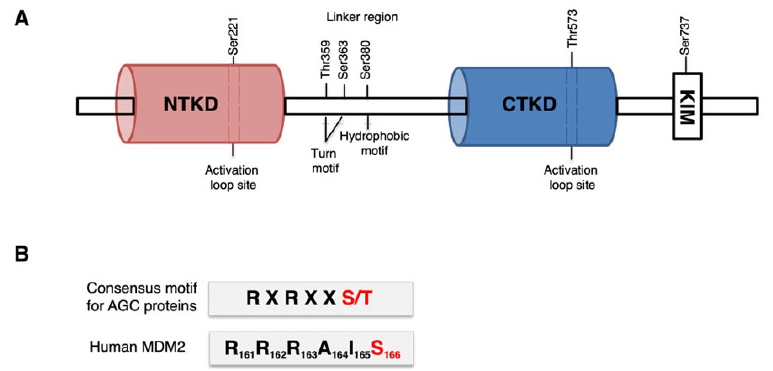
Figure 1. ( A ) Schematic representation of p90RSK structure. The N-terminal kinase domain (NTKD), the C-terminal kinase domain (CTKD), and the linker region were highlighted. The main phosphorylation sites were indicated, and the numbers refer to the RSK1 isoform; ( B ) representation of the consensus motif for AGC kinase family [7]. The S/T phosphorylation site is highlighted in red. The consensus sequence individuated in human MDM2 by www.phosphosite.org site (accessed on 14 November 2014) was indicated with the amino acid’s numbers.